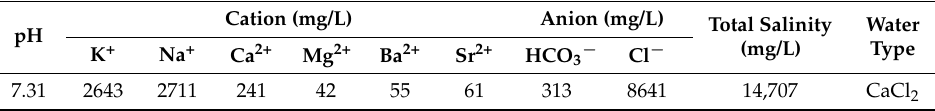
Table 2. Properties of simulated formation